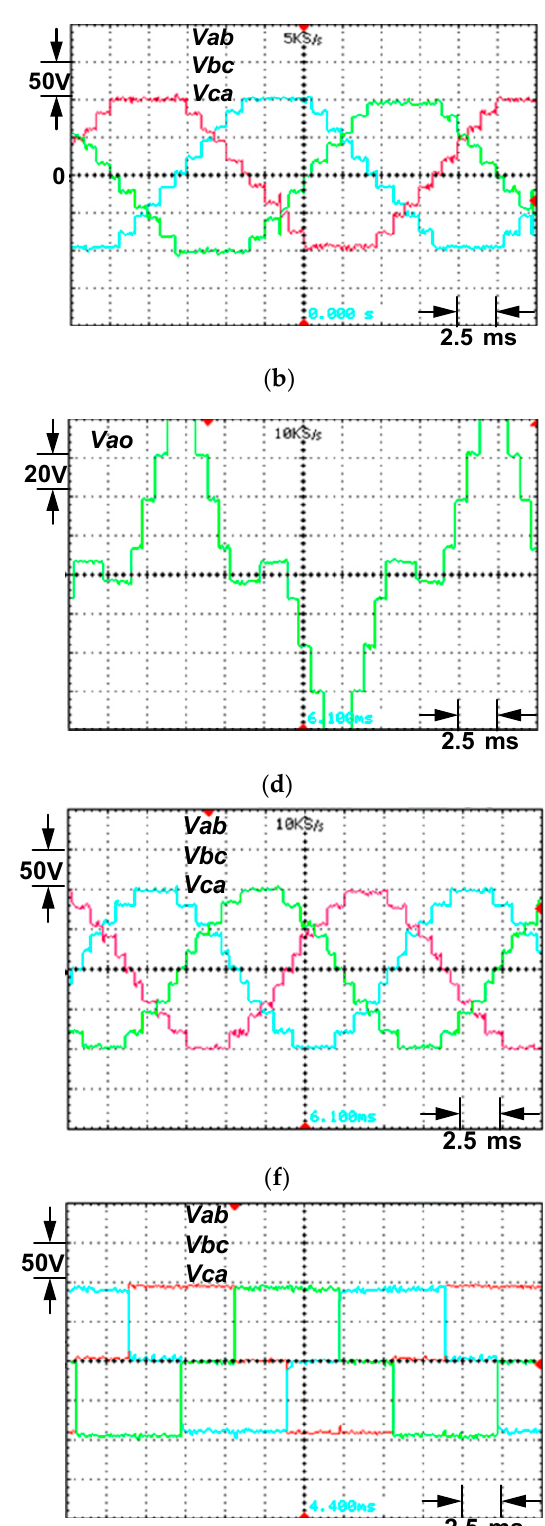
Figure 9. Control block diagram.